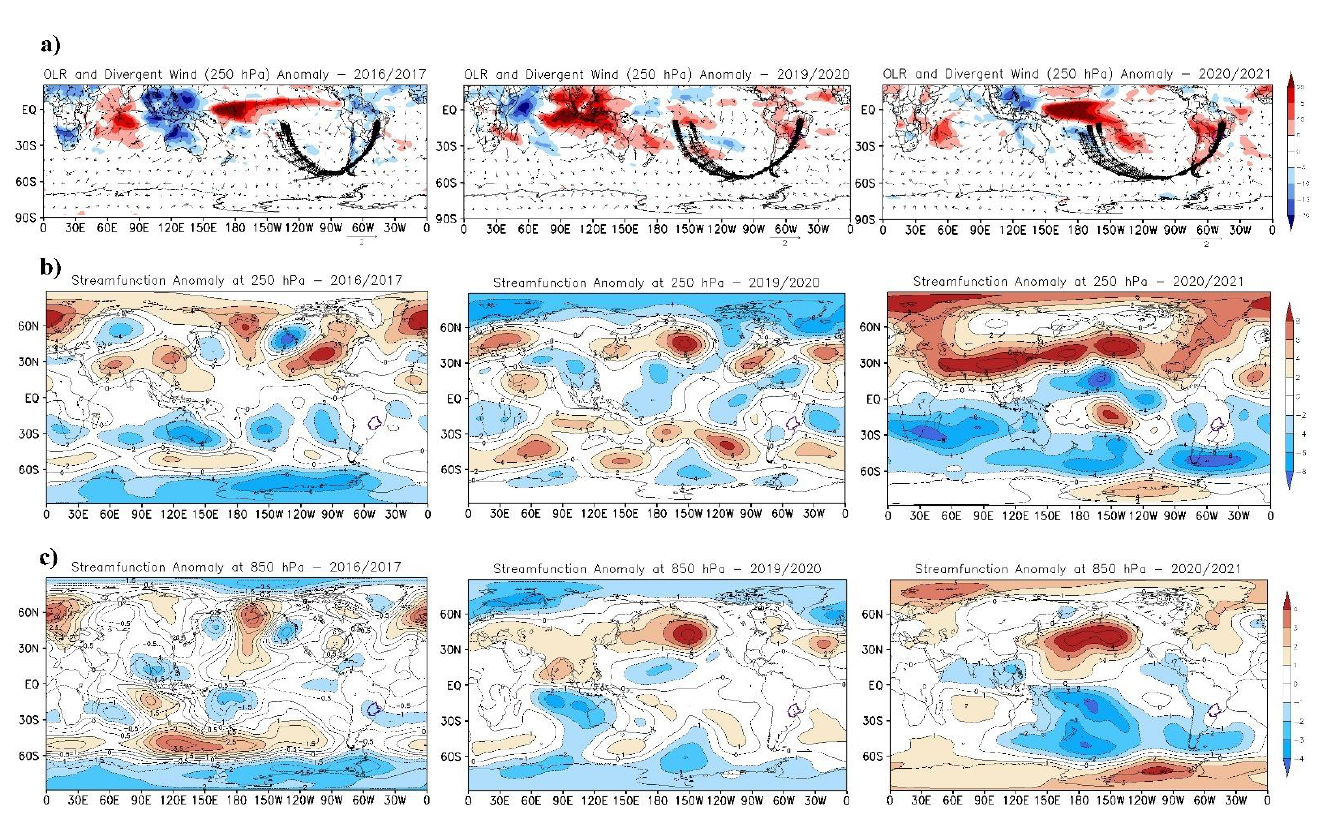
Figure 7. ( a ) OLR and divergent wind anomaly (250 hPa); stream function anomaly for levels ( b ) 250 hPa and (c) 850 hPa. The fields were plotted considering the subtraction of the Oct – Mar average, within the hydrological drought event, from the Oct – Mar climatology (1979 – 2021). The PHR is highlighted by a purple line and the wave train is indicated by the black dashed lines.